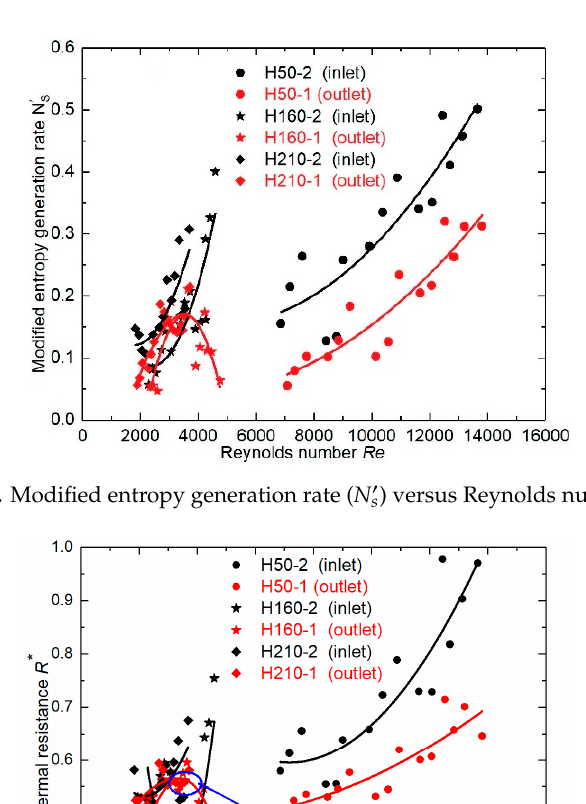
Figure 14. Dimensionless entransy dissipation rate-based thermal resistance R * versus Reynolds number 𝑅 (cid:3032) .